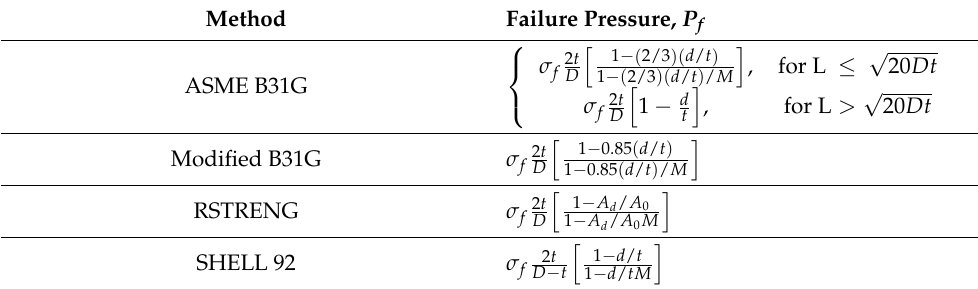
Table 2. Common pipe failure pressure assessment method equations [8–10].